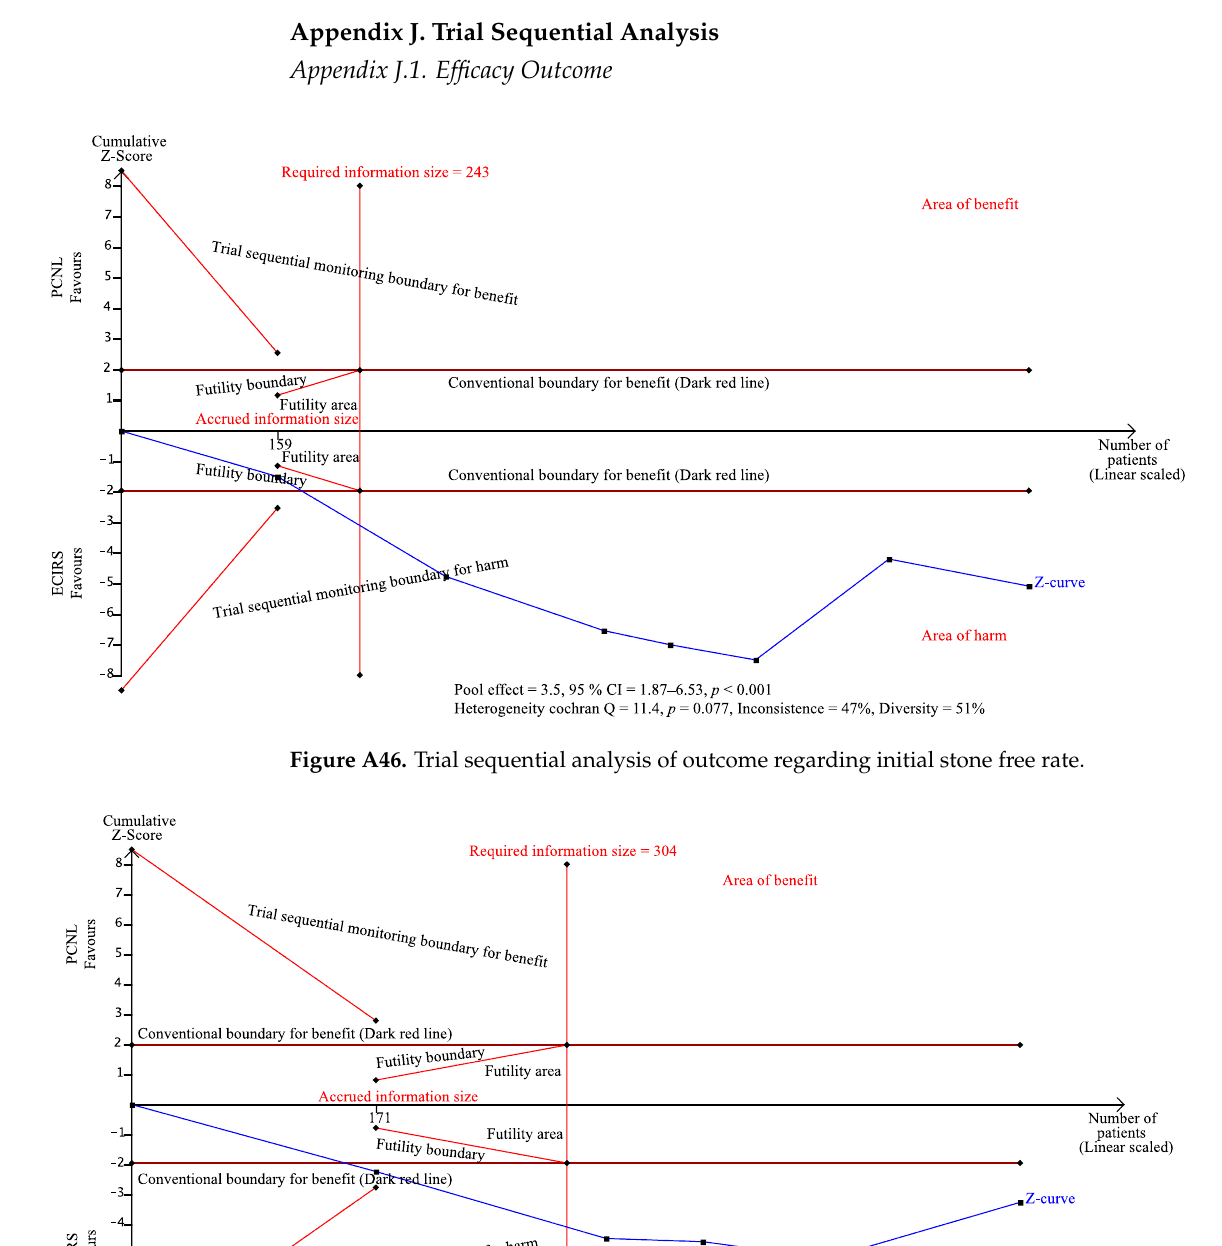
Figure A45. Comparison-adjusted funnel plot in outcome for hospital stay.